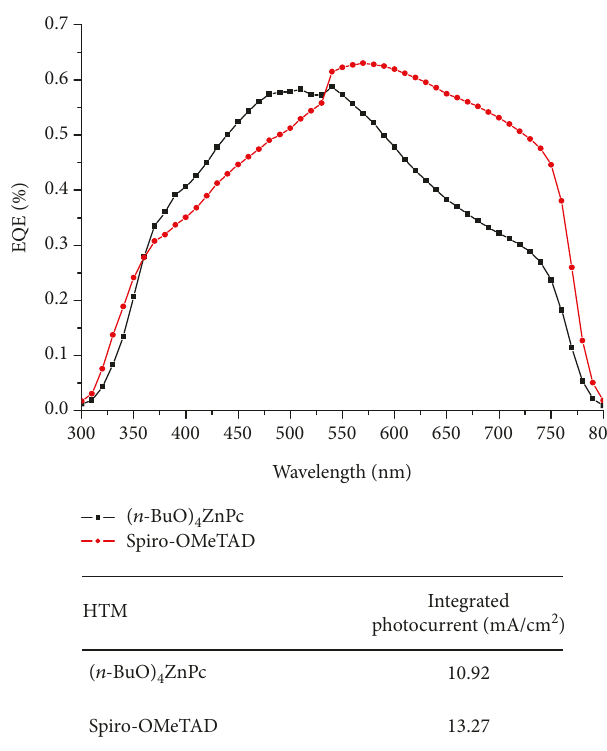
Figure 6: External quantum e ffi ciency graphs of ( n -BuO) (black line) and Spiro-OMeTAD-based PSCs (red Table 4: Calculated synthesis cost for 1g of ( n -BuO) Synthetic